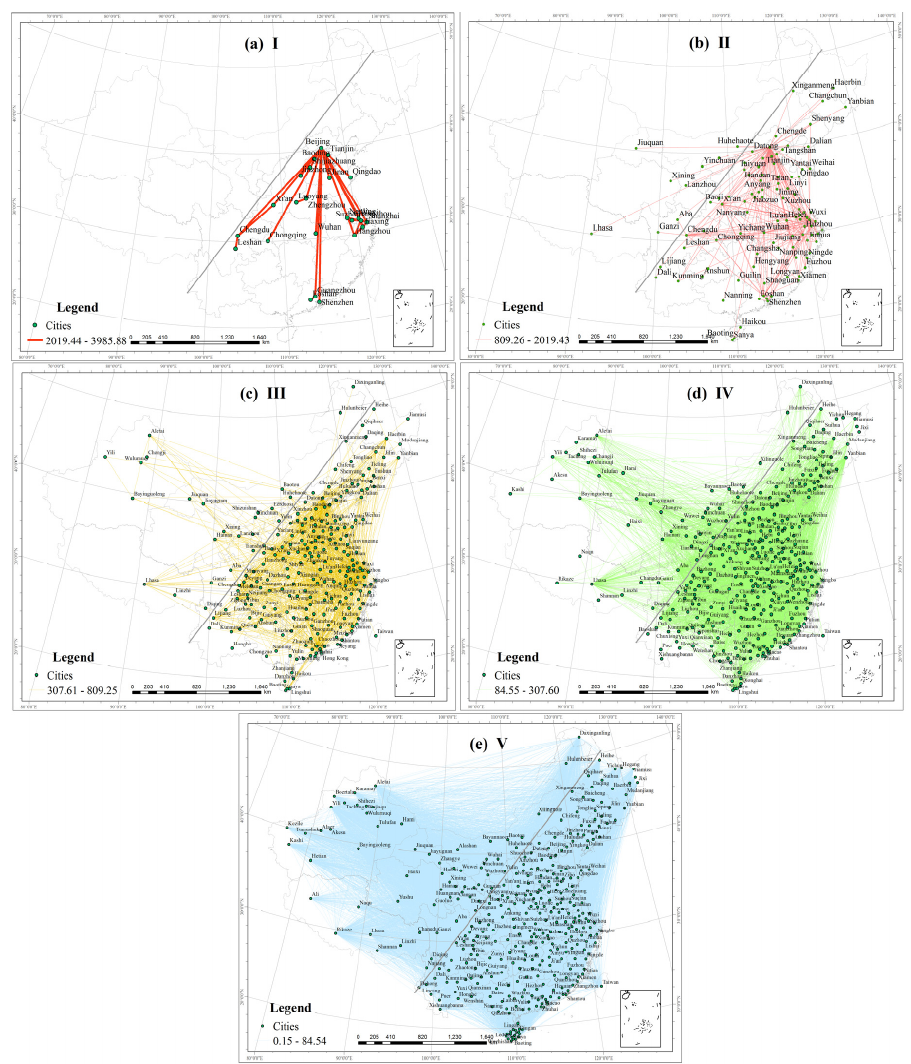
Figure 5. Association strength of the tourism information flows among cities. (( a ) represents the baidu index from 2019.44 to 3985.88, ( b ) represents from 809.26 to 2019.43, ( c ) represents from 307.61 to 809.25, ( d ) represents from 84.55 to 307.60, ( e ) represents from 0.15 to